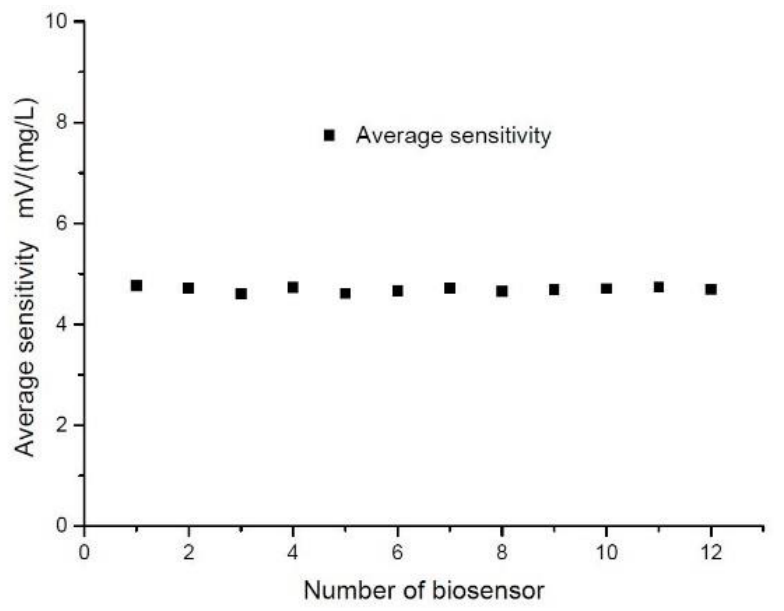
Figure 14. Reproducibility of the AgNW–uricase/rGO/NiO uric acid biosensor. Table 3. Average sensitivity for each AgNW–uricase/rGO/NiO uric acid biosensor. Number